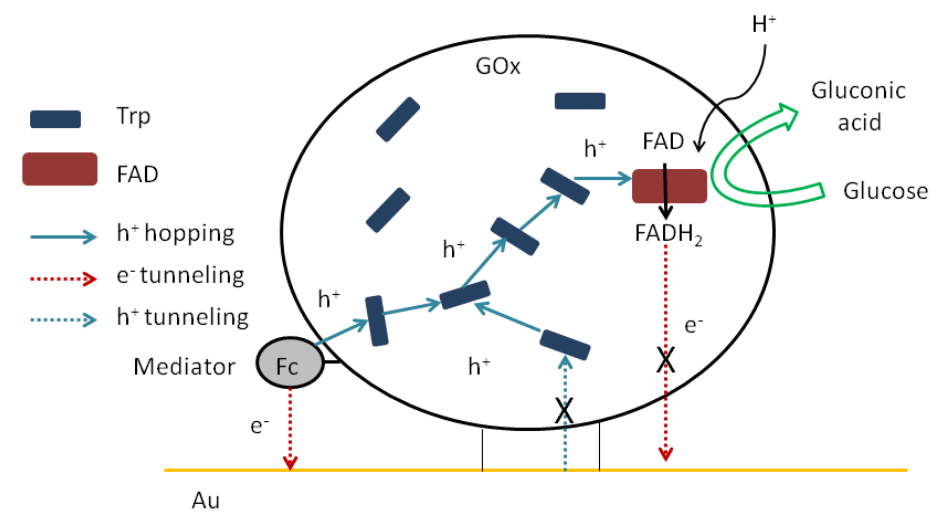
Scheme 1. Schematic drawing of glucose oxidation and hole hopping into Fc-functionalized